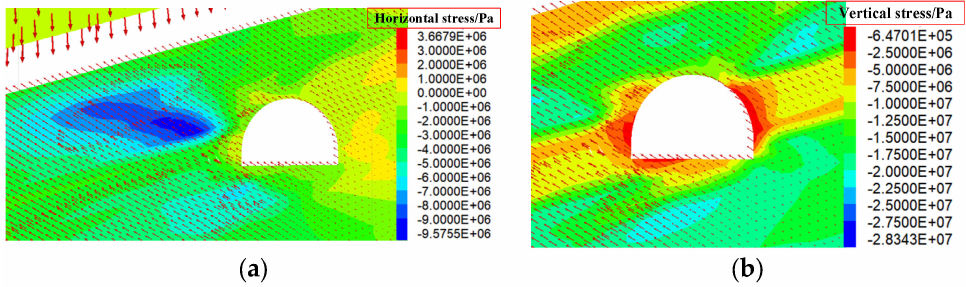
Figure 14. Distribution diagram of vertical stress and horizontal stress of a roadway. ( a ) Horizontal stress distribution. ( b ) Vertical stress